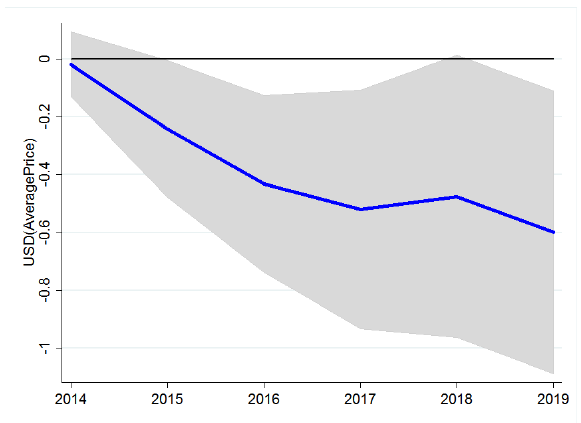
Figure 4. Cumulative Response of AveragePrice to Dummy2014.